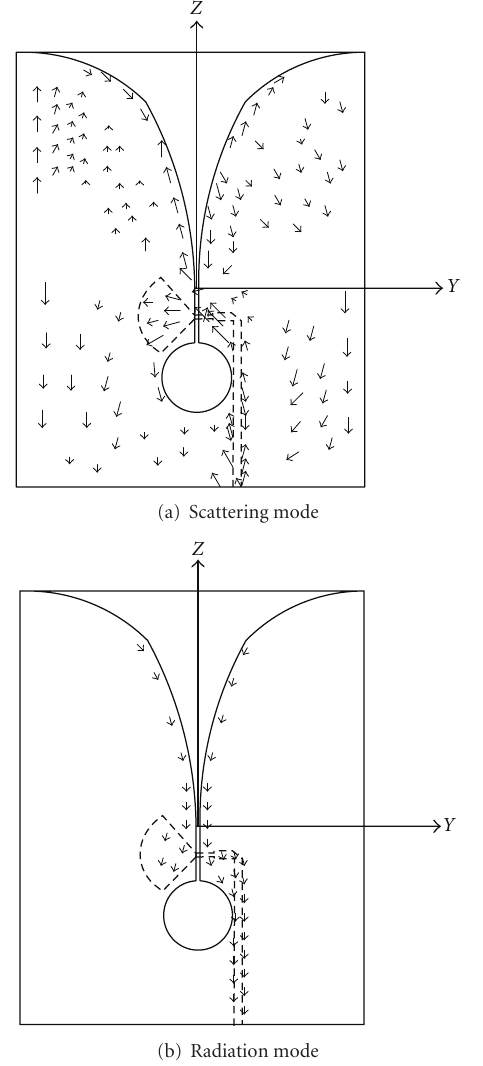
Figure 2: Current distribution of metal patch.